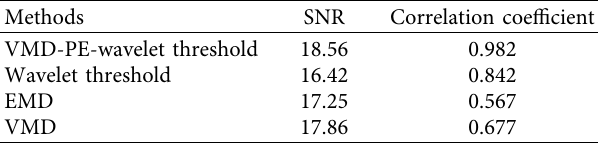
Table 5: Performance comparison of different denoising methods. Methods